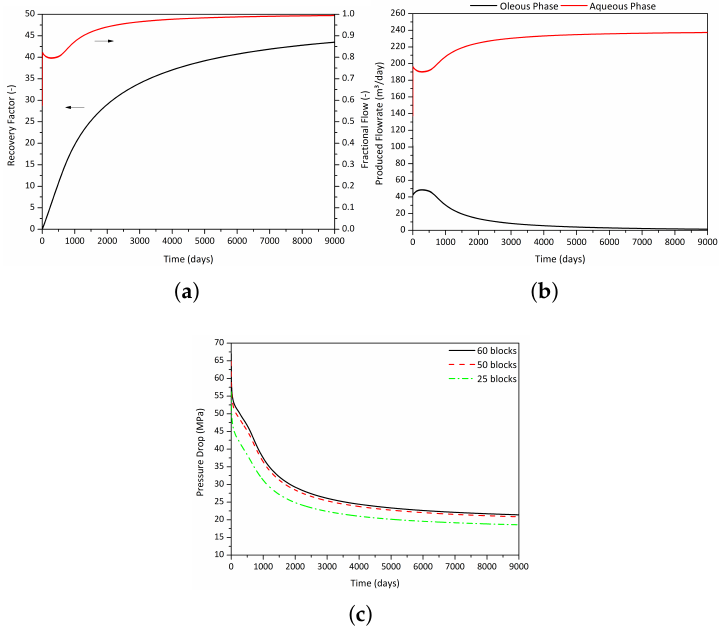
Figure 7. Cumulative oil production and fractional flow ( a ), oleous/aqueous produced flowrates ( b ); and pressure drop ( c ) for an iterative waterflooding